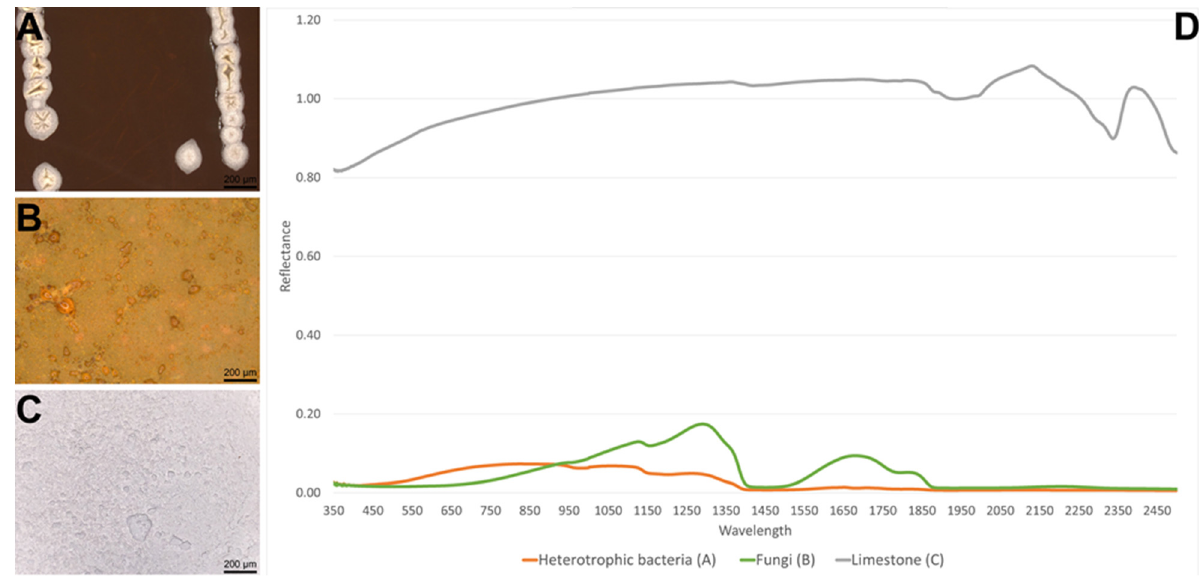
Figure 17. Keyence Digital Microscope images of colonies of isolated bacteria ( A ), fungi ( B ), and Dachstein limestone powder ( C ), which were subjected to re fl ectance analysis ( D ).